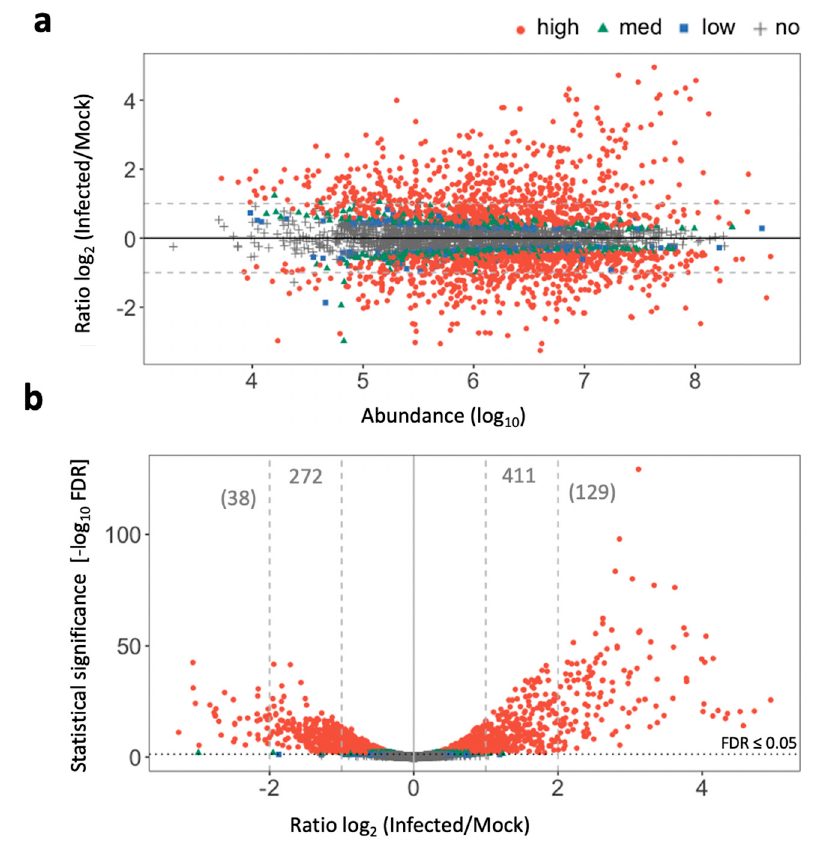
Figure 4. Juglans regia proteome in response to Xaj 417 infection showing 3296 detected proteins. ( a ) Ratio-abundance plot. ( b ) Volcano plot analysis of walnut hull infected with Xaj compared to the mock-inoculated hull. Colored dots show false discovery rate (FDR) confidence levels (red for high: FDR ≤ 0.01, green for med: FDR ≤ 0.05, blue for low: FDR ≤ 0.1, and grey for no: FDR > 0.1).